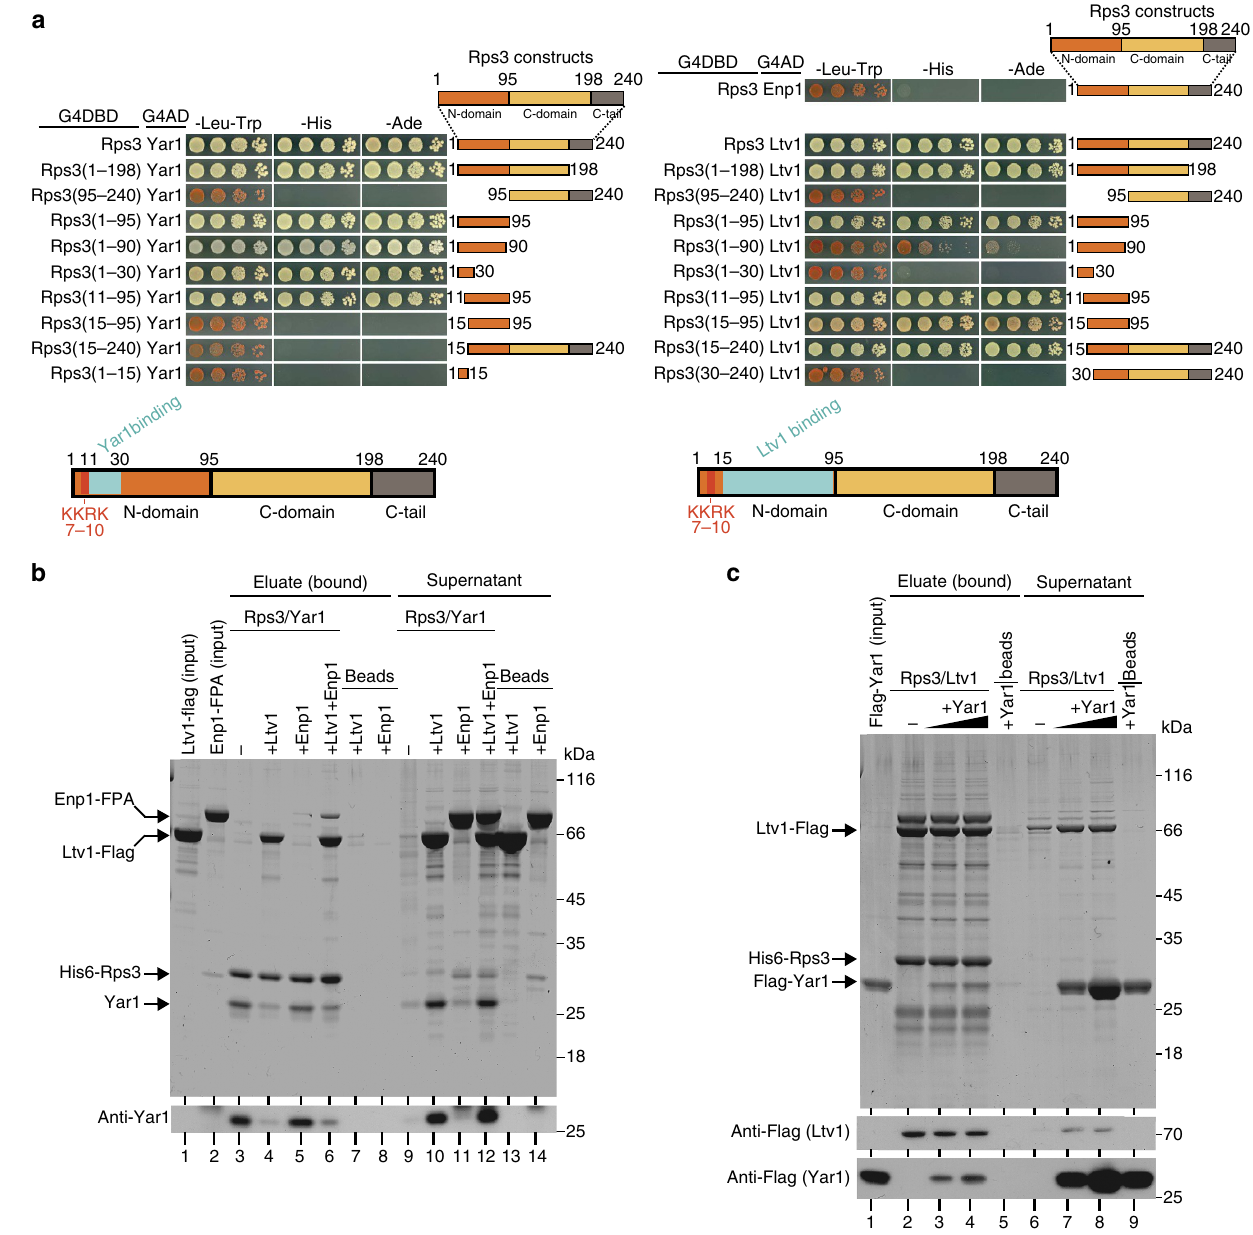
Figure 3 | Ltv1 releases Yar1 upon binding to the Rps3 N-domain. ( a ) Yar1 and Ltv1 have overlapping binding sites on the Rps3 N-domain. Different Rps3 truncations fused to the Gal4 DNA-binding domain (G4DBD) were tested for Y2H interaction with Yar1 (left panel), Enp1 or Ltv1 (right panel) fused to the Gal4 activation domain (G4AD). Growth on -His and -Ade plates, as well as white colony colour on -Leu-Trp plates, is indicative of a strong interaction. Both Yar1 and Ltv1 interact with N-terminal Rps3 fragments, whereas C-terminal Rps3 fragments do not mediate Y2H interaction with Yar1 or Ltv1. Below, the deduced binding domains, highlighted in blue colour, for each protein are illustrated schematically. ( b ) Ltv1 competes with Yar1 for Rps3 binding. Purified His6-Rps3/Yar1 complex immobilized on Ni-NTA agarose (and as control empty Ni-NTA agarose beads) was incubated either with buffer or with an B 6-fold molar excess (over Rps3) of purified Ltv1-Flag and/or Enp1-FPA (Flag-ProteinA). Supernatants of the incubation and eluates (containing His6-Rps3 and bound proteins) were analysed by SDS–PAGE and Coomassie staining or western blotting. ( c ) Yar1 competes only inefficiently with Ltv1 for Rps3 binding. Purified His6-Rps3/Ltv1-Flag complex immobilized on Ni-NTA agarose (and empty beads as negative control) was incubated either with buffer or with an B 1.5-fold (lanes 3 and 7) or 6-fold (lanes 4 and 8) molar excess of purified Flag-Yar1. Eluates containing His6-Rps3 and bound proteins and supernatants were analysed by SDS–PAGE and Coomassie staining or western